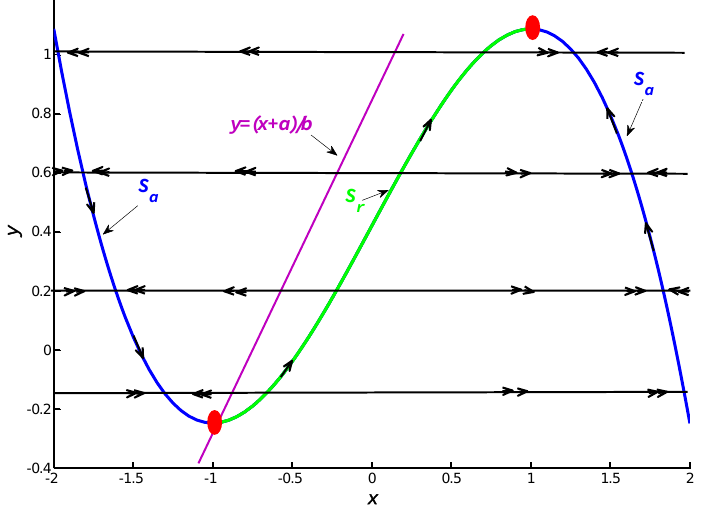
F IGURE 4 Fractional-order fast and slow subsystems of system (10). Single arrows indicate slow motions along the slow curve S 0 . Double arrows indicate fast motions outside S 0 , which possesses two attracting branches, S a , and one repelling branch, S r , separated by fold points (red) of the slow curve, corresponding to saddle-node bifurcation points of the fast